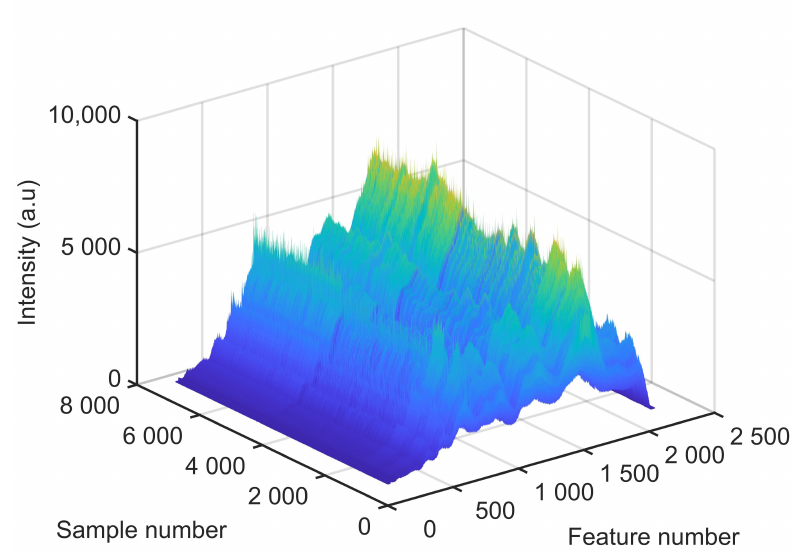
Figure 4. Time series of spectral data acquired during the tests. Each feature represents discrete wavelengths of the spectrum while the sample number represents the time sequence acquired during the